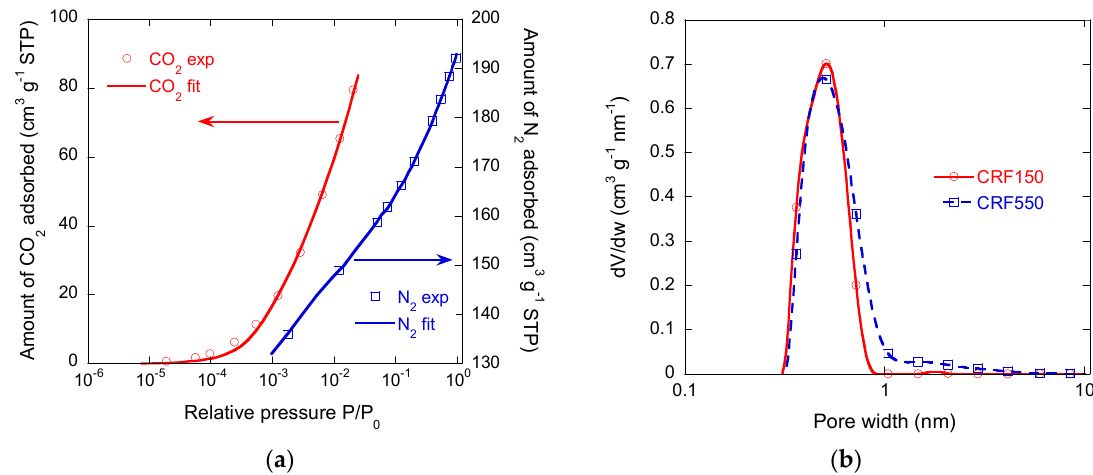
Figure 5. ( a ) Fits by SAIEUS ® software (full lines) of the experimental N 2 (blue squares) and CO 2 (red circles) isotherms of the CRF550 sample; ( b ) corresponding pore size distribution; and comparison with that of CRF150 sample. Table 3. Pore texture characteristics of cellular carbon monoliths derived from Figure 5.